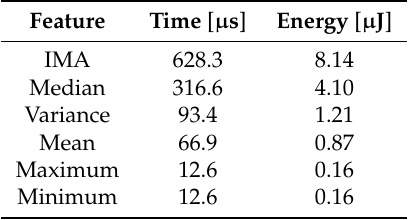
Table 9. Feature computation cost over 32